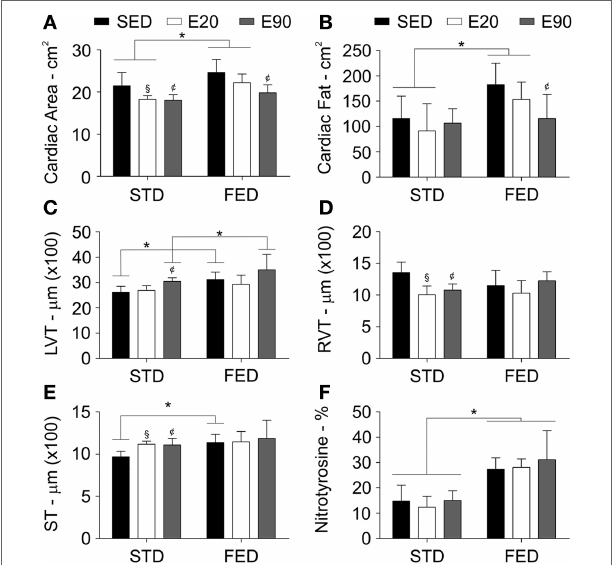
FigUre 3 | Physical exercises do not protect the heart from side effects of a fat-enriched diet (FeD) . Computerized tomography analyzed the heart area (a) , and the cardiac fat tissue density (B) . A histopathological analysis determined the thickness (micrometer) of the left ventricle [LVT; (c) ], the right ventricle [RVT; (D) ], and the septum [ST; (e) ]. Staining heart samples with anti-nitrotyrosine antibody determined damage in this tissue (F) . Statistical Analysis I: ¢ p < 0.05 vs STD-SED of FED-SED; § p < 0.05 vs STD-SED. Statistical Analysis II: * p < 0.05. Data analysis: two-way ANOVA test (Bonferroni’s post hoc test). Reported values are the mean ± SD.